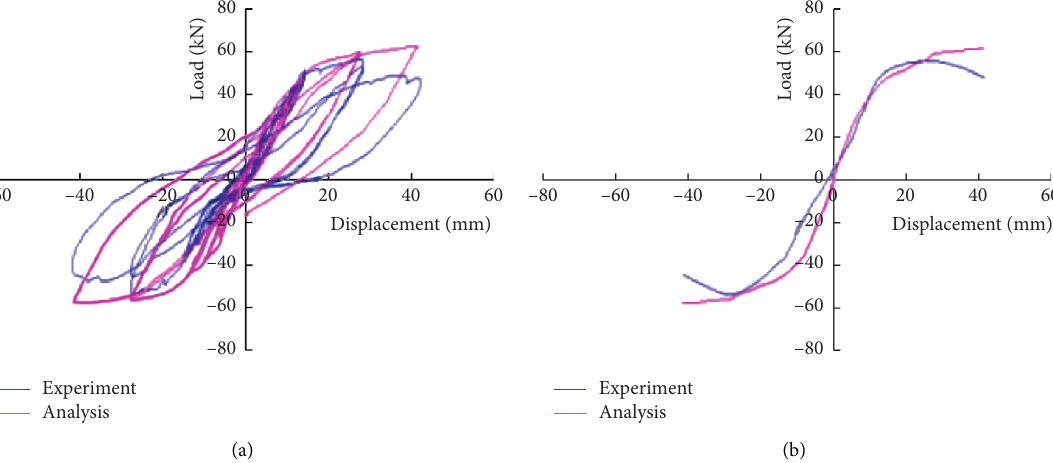
Figure 9: Comparison of the hysteretic curves and skeleton curve of model 1 (after): (a) hysteretic reinforcement; (b) skeleton reinforcement.